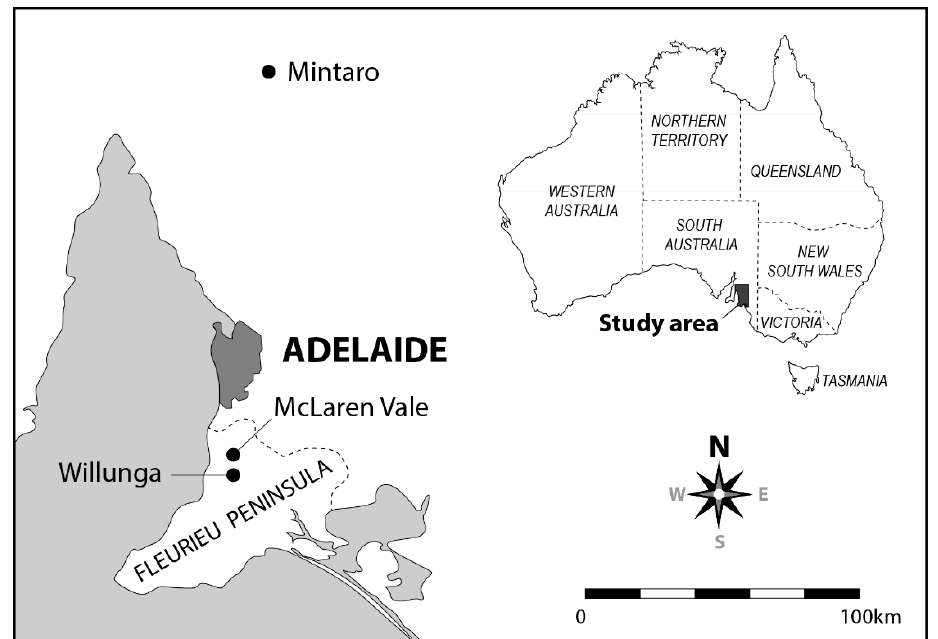
Figure 1. Places referred to in the text.